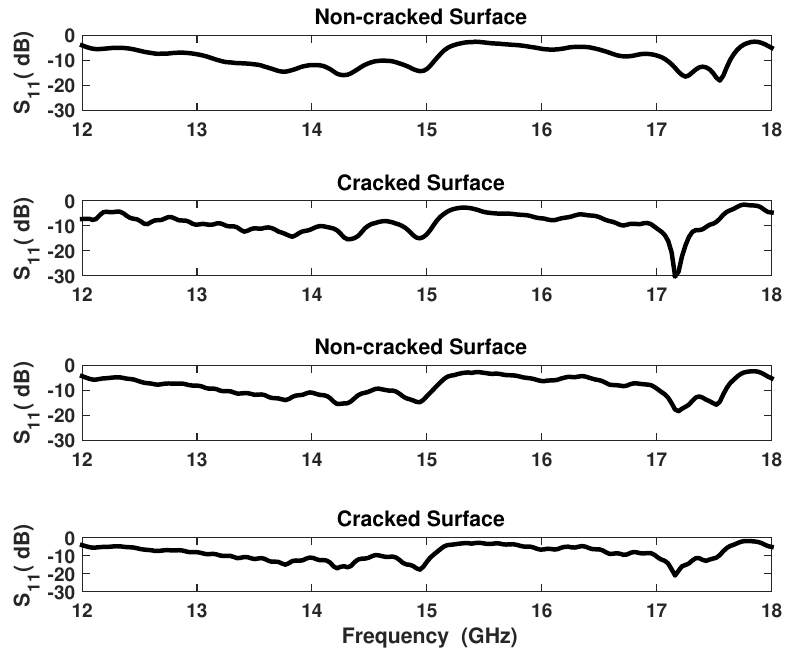
Figure 5. Reflection coefficient magnitude from different cracked and non-cracked